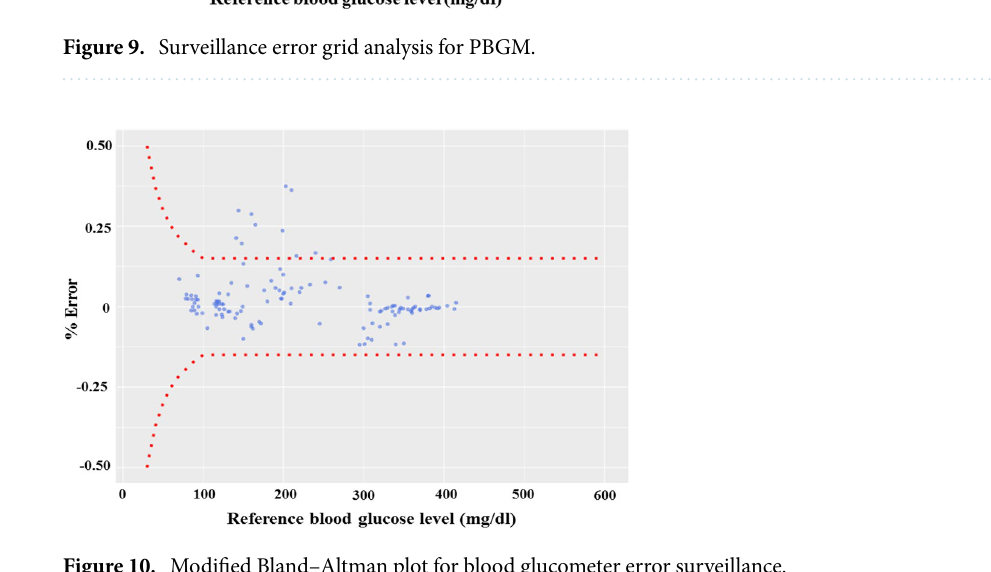
Figure 10. Modified Bland–Altman plot for blood glucometer error surveillance.